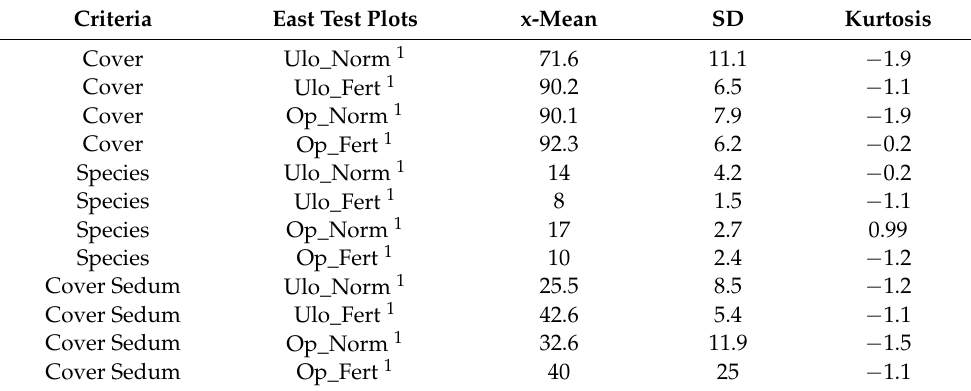
Table 10. Greening with sedum cuttings, n = 9 years, from 2011 to 2020. The coverage and number of species of the test plots with fertilizer (Fert.) and without (Norm.) for the eastern exposure. Mean value, standard deviation, and kurtosis. The negative kurtosis value indicates that the distribution is characterized by weaker marginal areas than the normal